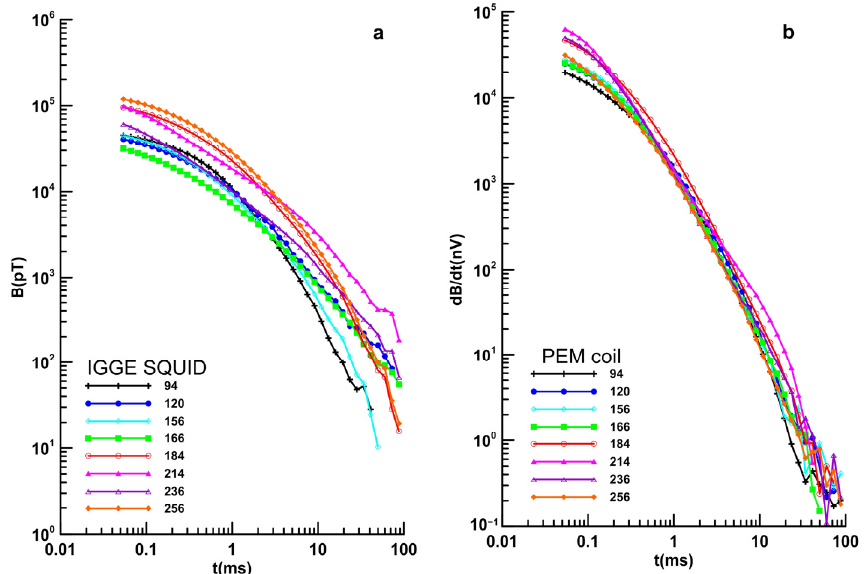
Figure 5. Comparison of SQUID magnetometer and coil decay curves. ( a ) TEM decay curves of IGGE SQUID data; ( b ) TEM decay curves of PEM coil data.